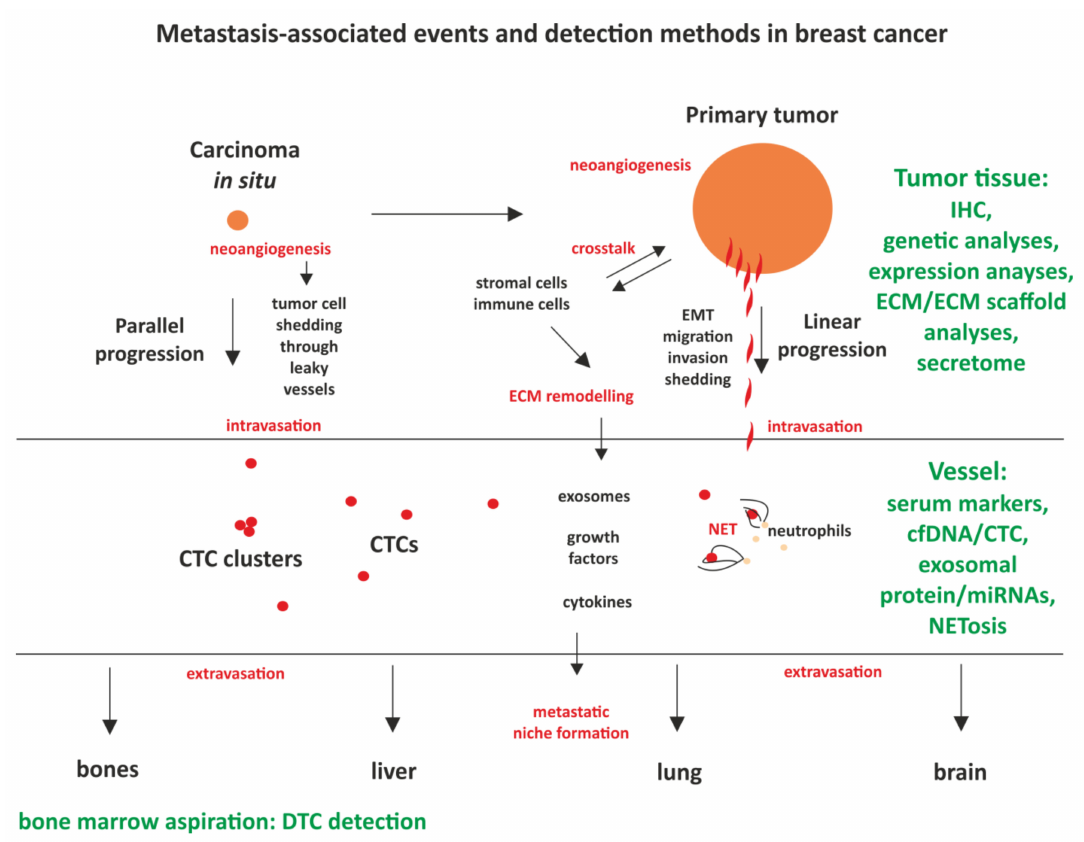
Figure 2. Metastasis-associated events and the methods of their detection in breast cancer